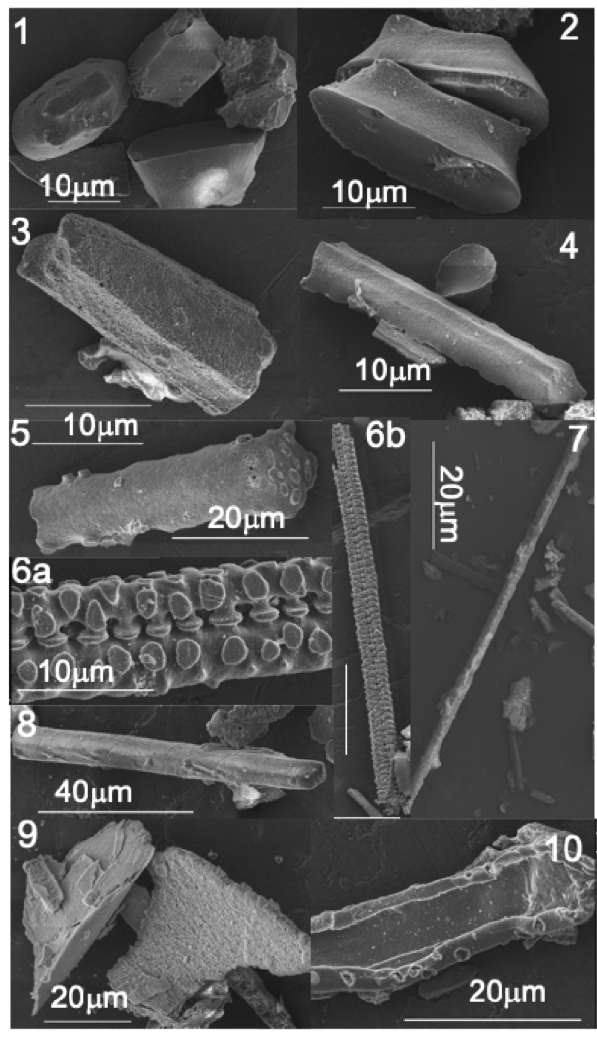
Figure 1. Growth chamber experiment 1: SEM pictures of phy- toliths from young, adult and senescent leaf blade: silicified trapez- iform short cell (1, 2 and 3), silicified trapeziform sinuate short cell (4), undefined silicified short cell or broken elongate cylindric long cell (5), silicified elongate cylindric long cell (6a, 6b, 7 and 8) and silicified cell wall also reported as silica sheets (9 and